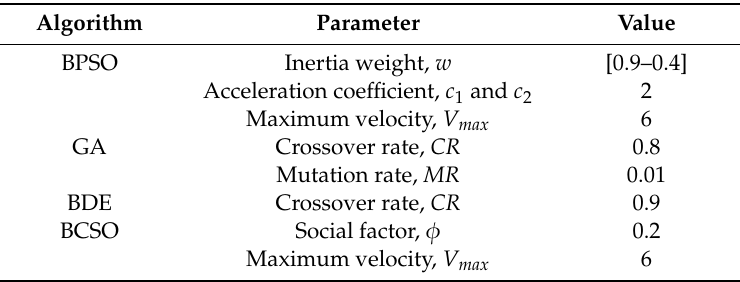
Table 2. Parameter settings of the utilized